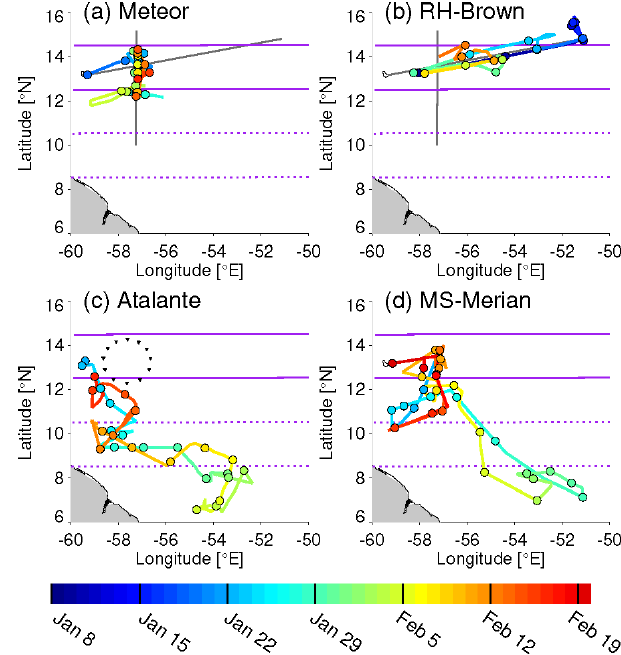
Figure 2. Routes and launch coordinates of radiosondes for the four research vessels colored by date. Circles mark the locations of the first radiosonde launch on each day. The gray lines in panels (a) and (b) mark the nearly orthogonal lines that were sampled by Me- teor (north–south) and Brown (west–east). Purple lines mark the northern (12.5–14.5 ◦ N; solid) and southern (8.5–10.5 ◦ N; dashed) latitude bands that we later use to define a north (Trade-wind Alley) and south (Boulevard des Tourbillons) domain. Downward-pointing black triangles in panel (c) mark the locations of dropsonde releases during regular circular aircraft